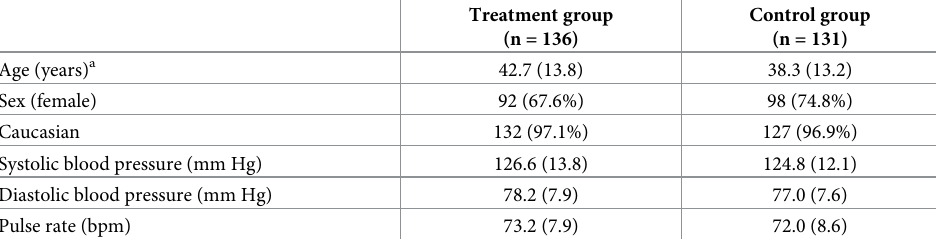
Table 1. Baseline characteristics of the full analysis set (FAS)